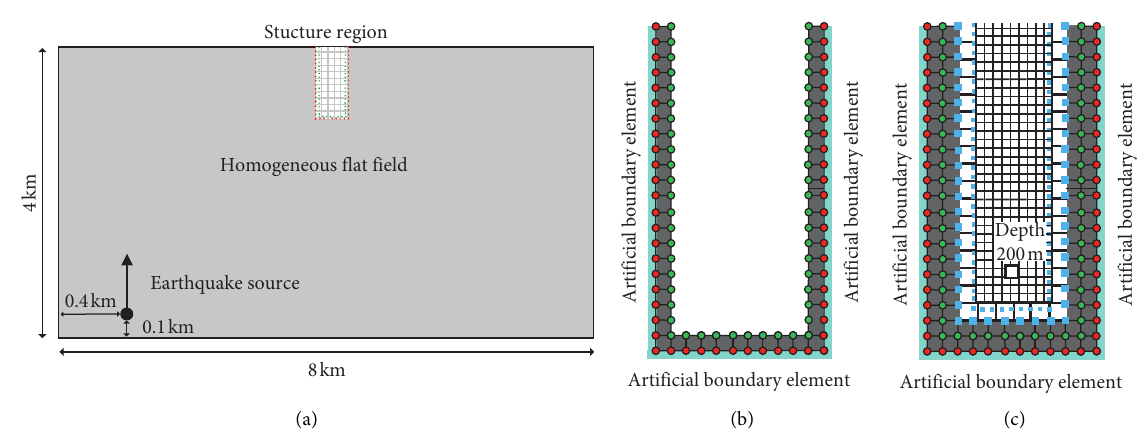
Figure 14: Model of Example 4.1.2 (burial depth is 200m): (a) the source-site model, (b) artificial boundary substructure, and (c) SSI